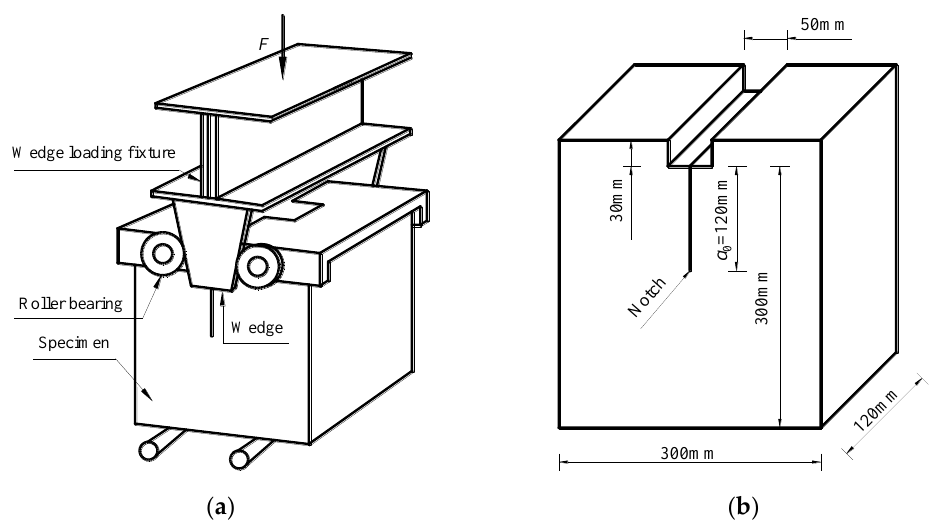
Figure 1. The fracture test specimen: ( a ) principle of wedge splitting test method; ( b ) the dimension of the specimen.